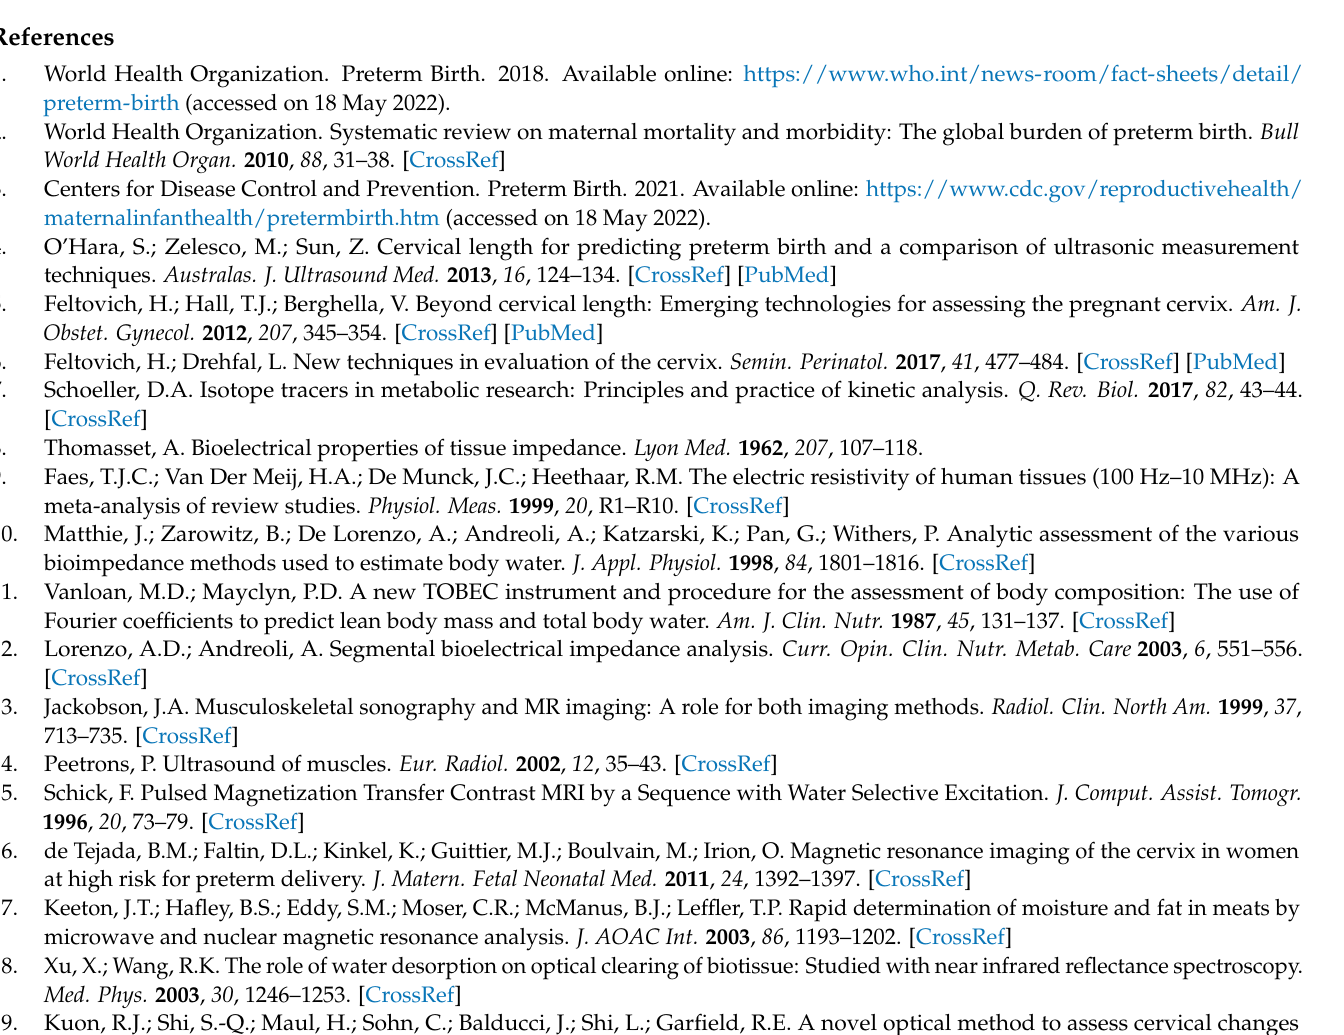
Figure A1. Accuracy comparison of Corneometer and the harmonic resonant coaxial probe with respect to weight-based water content for sample A. ( a ) correlation chart, and ( b ) regular residual data after linear fit.